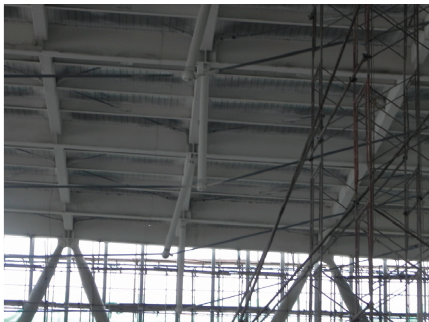
Figure 1: Cable clamp sliding along the cable of a beam-string structure.